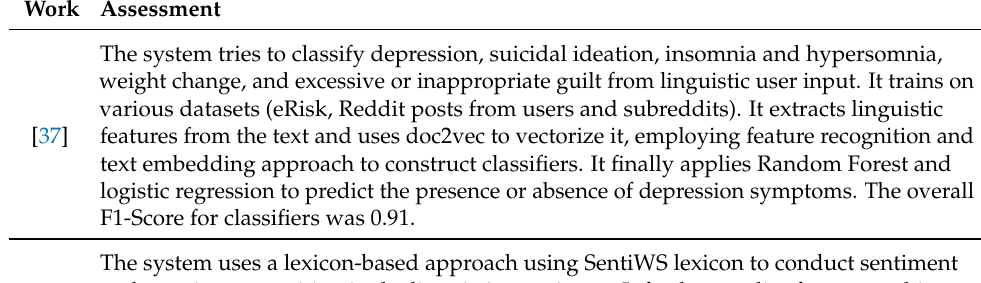
Table 2. Answering RQ2. Which technologies, methods and collected data guide the process to achieve ABC for SAD in the systems? First step in the process: